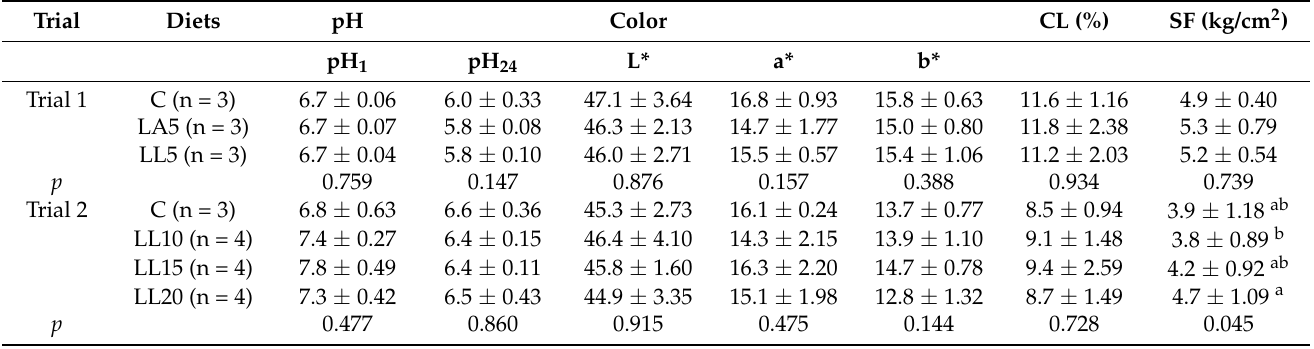
Table 4. Least square means ( ± SE) of meat quality attributes of lambs in trials 1 and